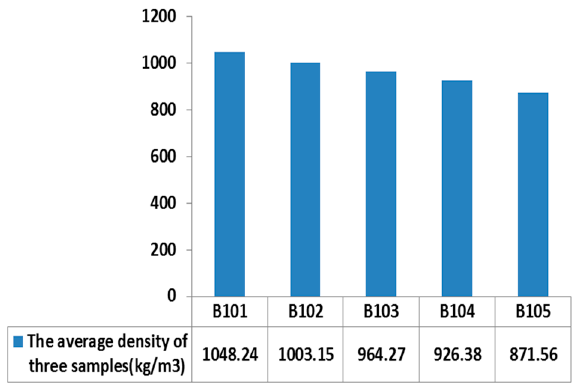
Figure 8. The test results of density (kg/m 3 ).